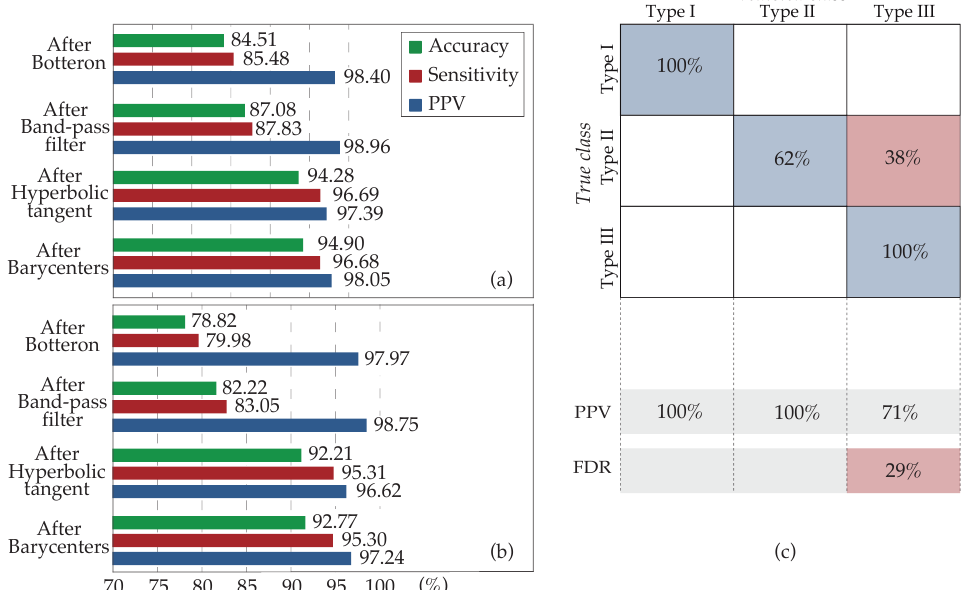
Figure 9. Progressive results of the method application by stages. ( a ) Over the entire dataset and ( b ) over the type III AF EGMs exclusively. Four cases are analyzed: the application of the algorithm only with the Botteron preprocessing (After Botteron), after the band-pass modification to 20–250 Hz (After Band-pass filter), adding the HT use (After Hyperbolic tangent), and, finally, with the estimation of barycenters and the deletion of close activations (After Barycenters). ( c ) Confusion matrix for the classification of the recordings according to their fractionation. True class: experts’ classification; Predicted class: kurtosis classification; PPV: positive predictive value; FDR: false discovery